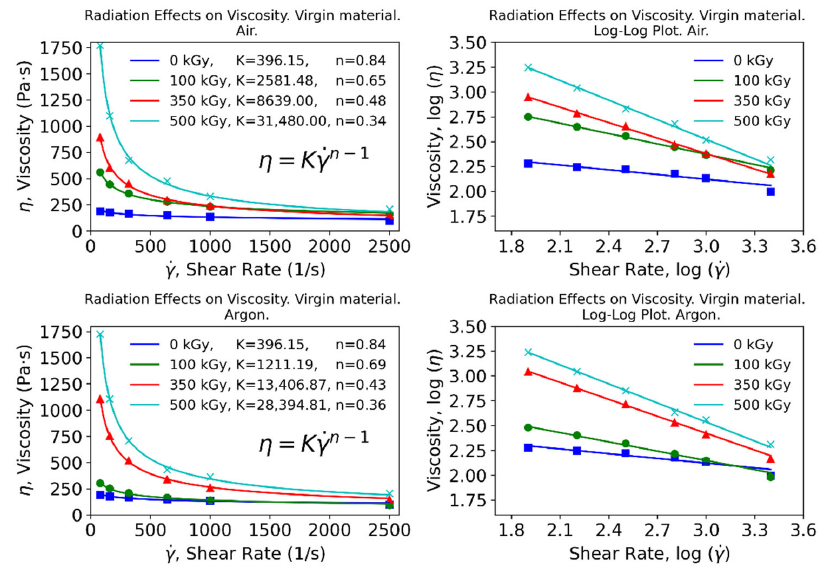
Figure 3. Apparent viscosity for virgin material at different absorbed doses. Top: irradiation in air. Bottom: inert atmosphere.